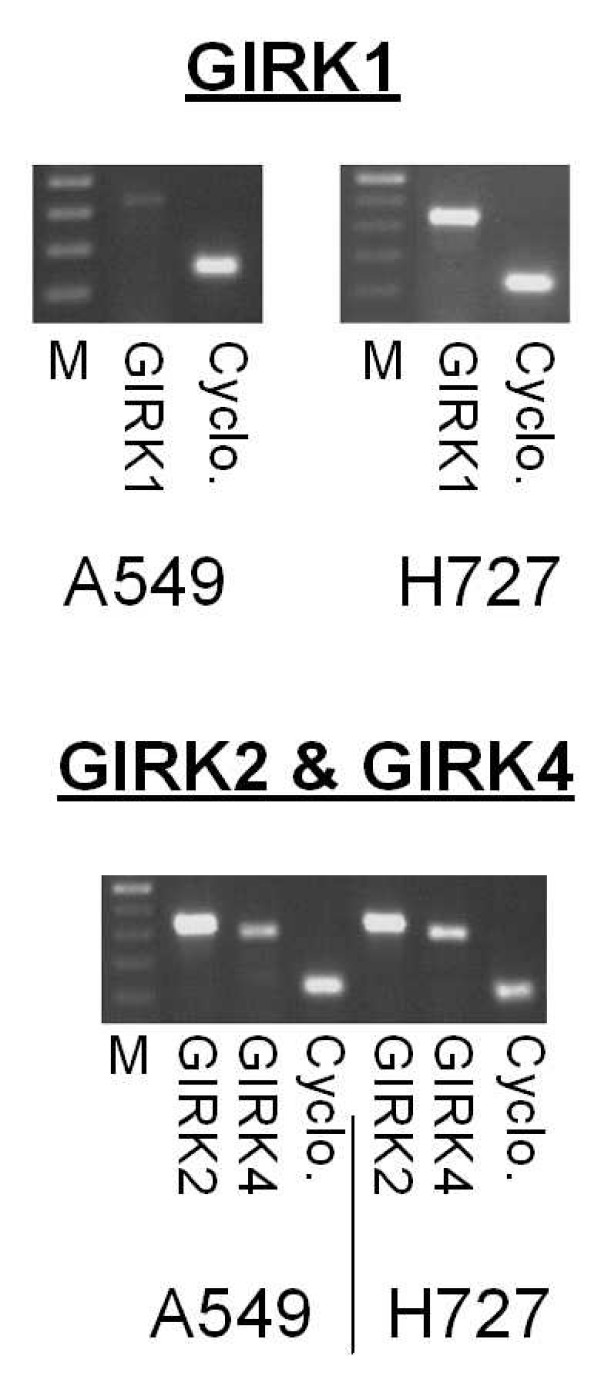
Expression of GIRK channels in adenocarcinoma alveolar type II cell phenotype (A549) and carcinoid (H727) cell lines. Top panel: GIRK1 was expressed in both A549 and H727 cell lines. Bottom panel: Both A549 and H727 expressed GIRK2 and GIRK4. Cyclophilin, used as a positive reaction control was seen in both samples. For all gene expression experiments, negative control reactions were performed and found to be negative. The bands on the agarose gels were consistent with the expected sizes: GIRK1-441 bp; GIRK2-438 bp; GIRK4-401 bp; cyclophilin-216 bp; M-100 bp.